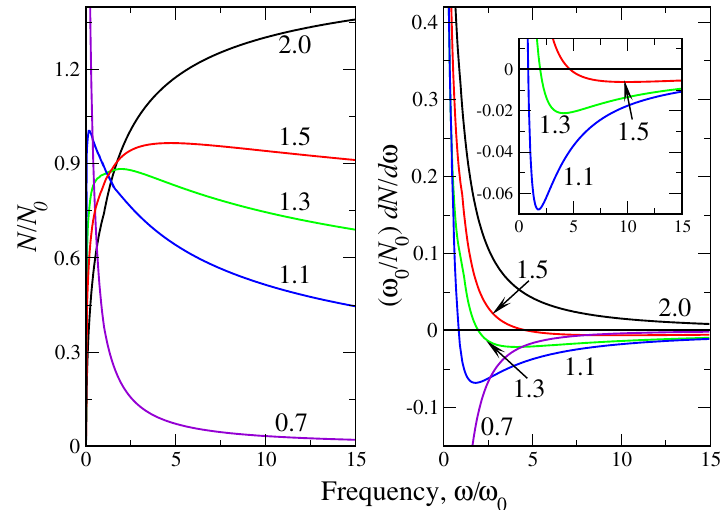
Figure 2. The dimensionless fractional soliton norm, calculated variationally (left panel) and its frequency derivative (right panel). Figures near curves in both panels correspond to the Lévy indices α . Inset in right panel shows the negative parts of dN / d ω for 1.1 < α < 1.5 in larger